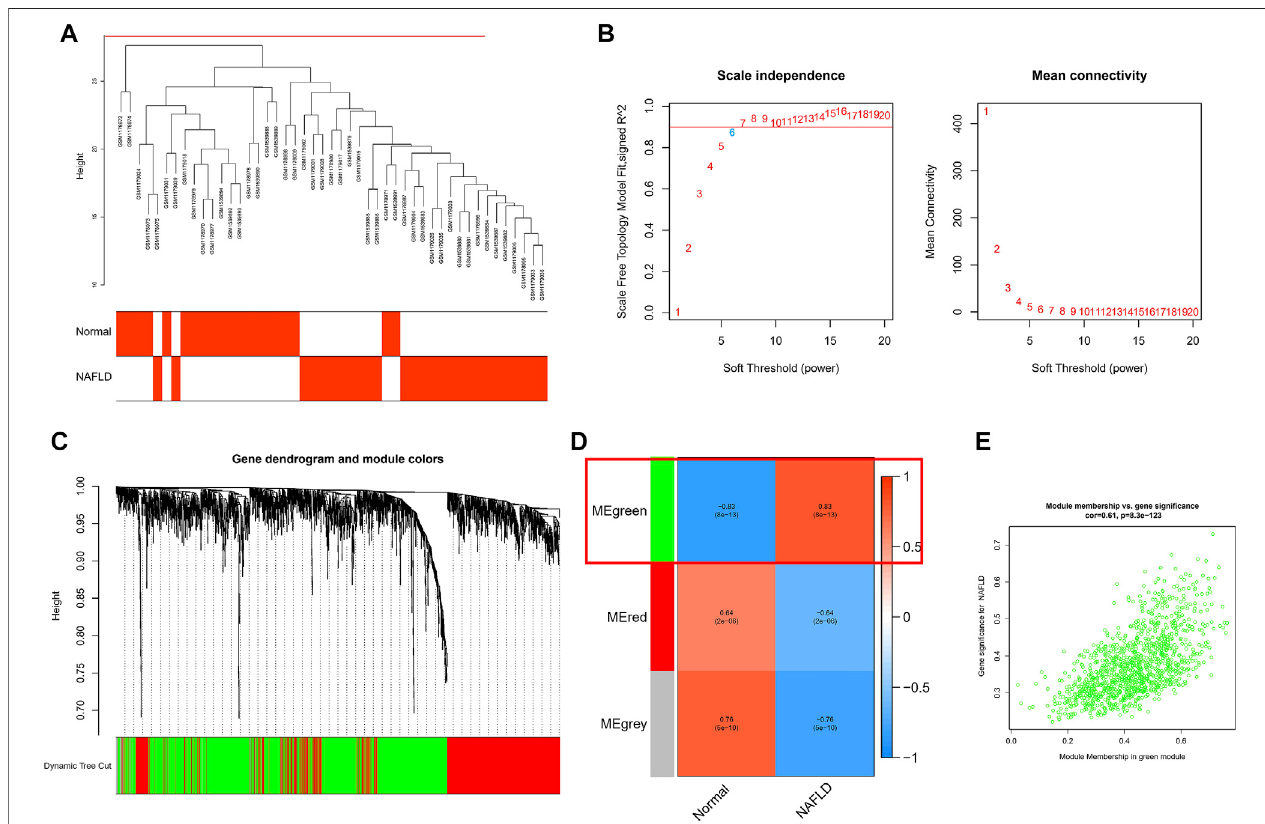
FIGURE 3 | WCGNA analysis was used for further screening. (A) Each sample clustered well, with a shear line of 30 as the threshold and one case of outlier removed. (B) Topologicalcalculationswith softthresholdsfrom 1to20todetermine the optimal soft threshold of6. (C) Based onsoft thresholds,therelationship matrix isconvertedtoanadjacencymatrixandthentoatopologicaloverlapmatrix(TOM)foraveragelinkhierarchyclustering,whichclassi fi estherelevantmodulesaccordingto TOM. (D) Calculating the correlation between genes within modules and clinical traits, we found that the green module had the highest correlation with the occurrence of NAFLD ( p = 0.83). (E) The scatter plot of the correlation between GS and MM for 1,196 genes within the green